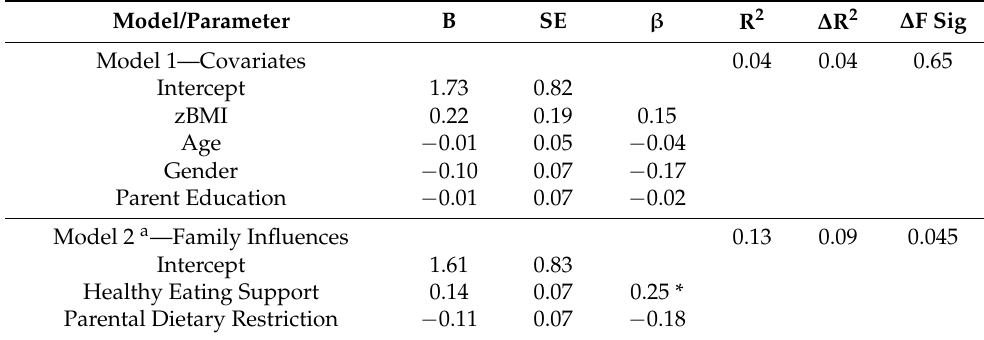
Table 3. Regression analyses assessing associations of family factors and weight loss motivators with healthy weight